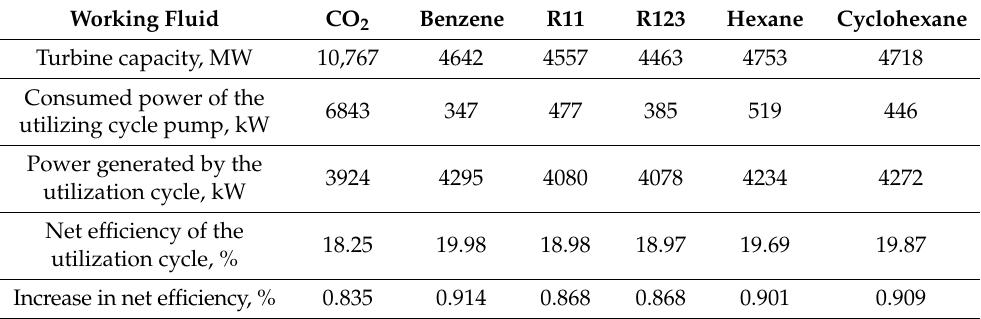
Table 5. Characteristics of low-potential heat sources of OFPP. Table 5. Calculation results for cycles using low-grade heat.